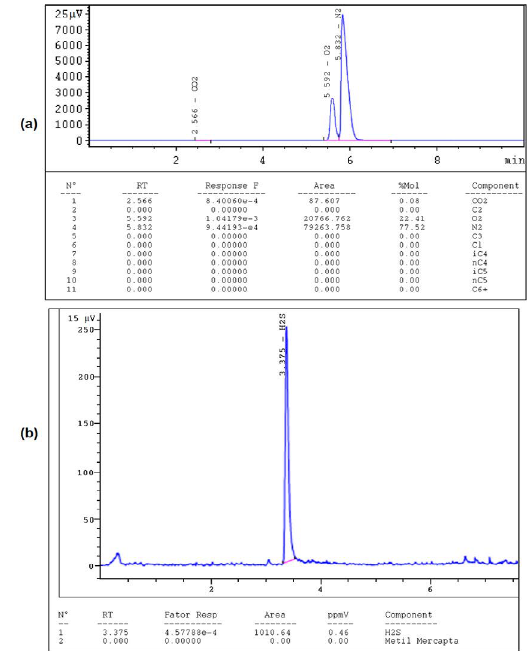
Figure 3. Gas chromatography (GC-SCD) of the Sulfatreat